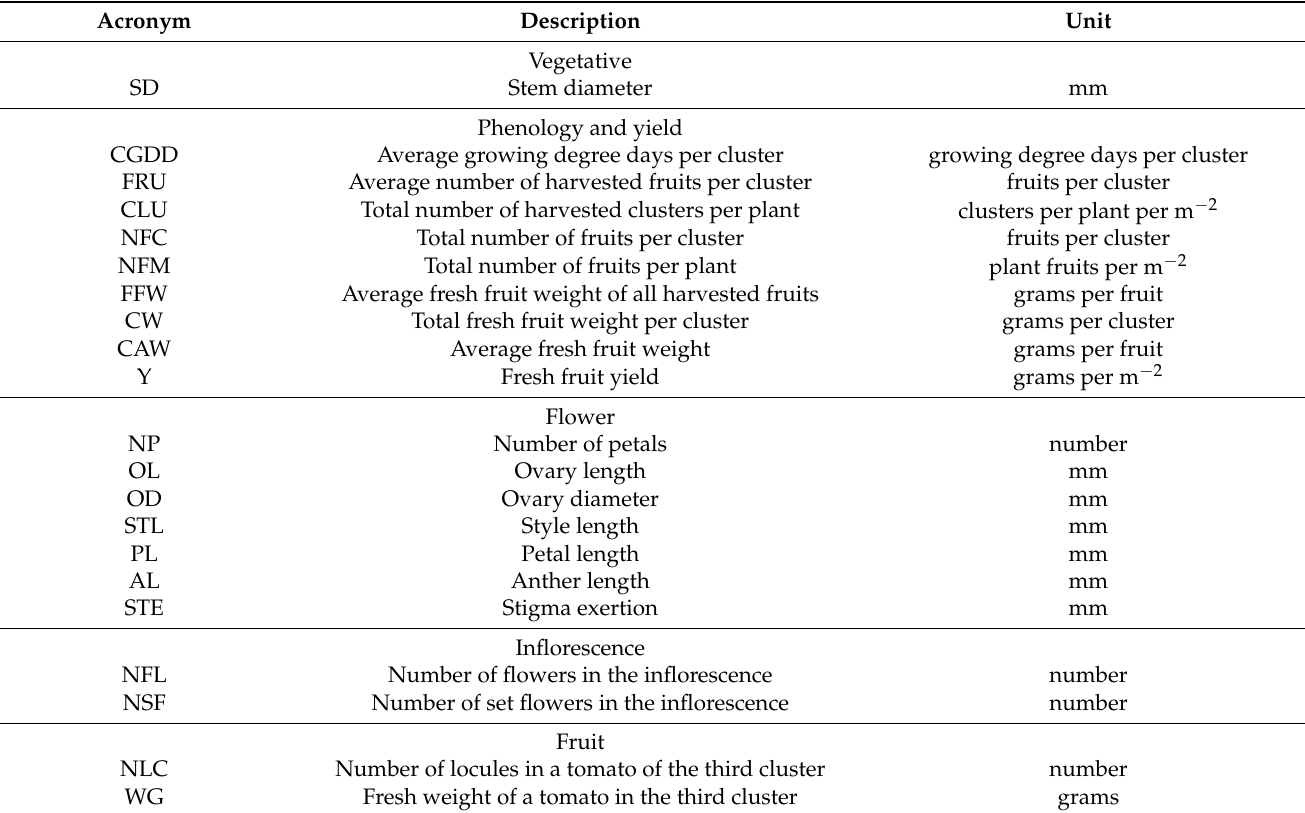
Table 2. Phenotypic descriptors evaluated in this